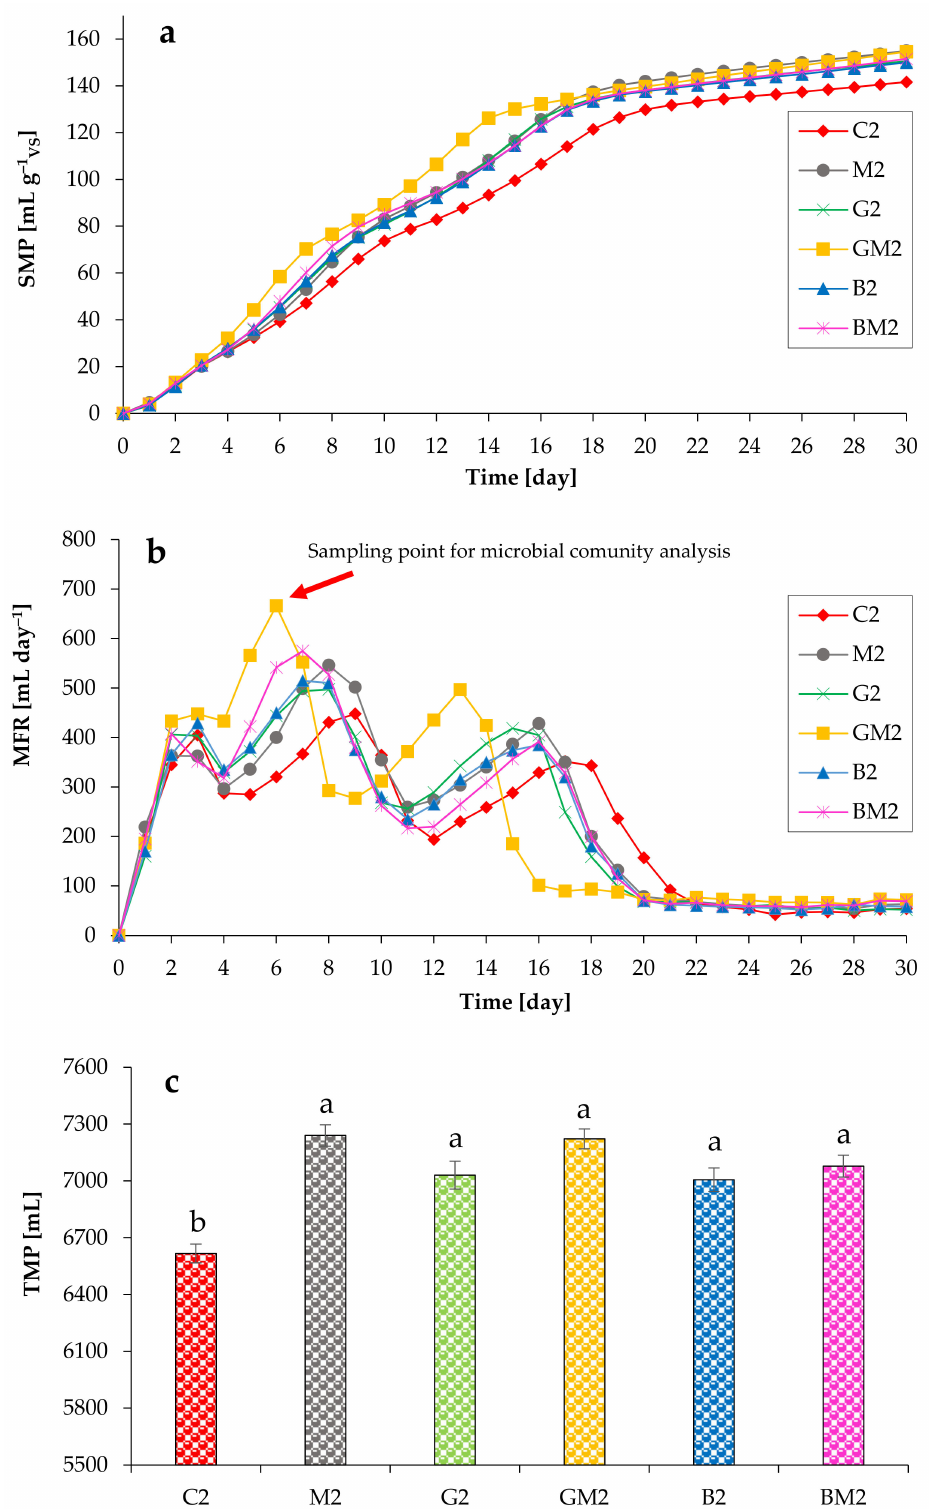
Figure 3. Impact of various additives on SMP ( a ), MFR ( b ), and TMP ( c ) during anaerobic digestion of chicken manure (TS of 7%). Means that do not share a letter are significantly different ( c